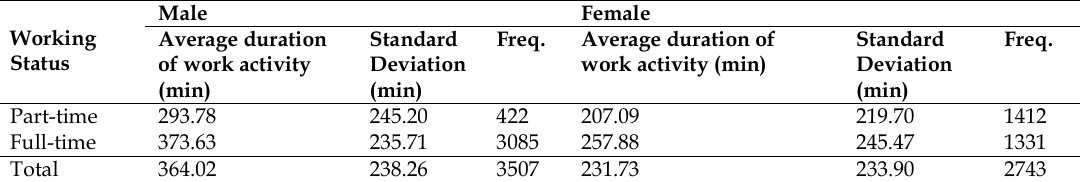
Table 4. Work duration statistics by work status and